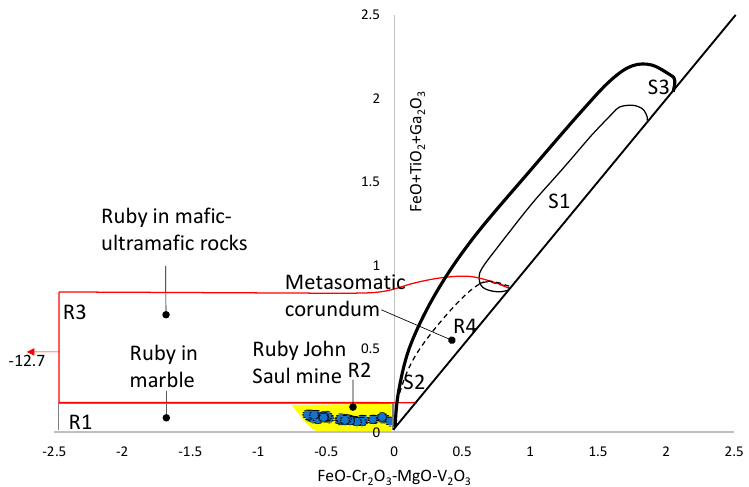
Figure 8. A FeO–Cr 2 O 3 –MgO–V 2 O 3 vs. FeO–TiO 2 –Ga 2 O 3 diagram (in wt%) for rubies from the Snezhnoe deposit, modified after [34].